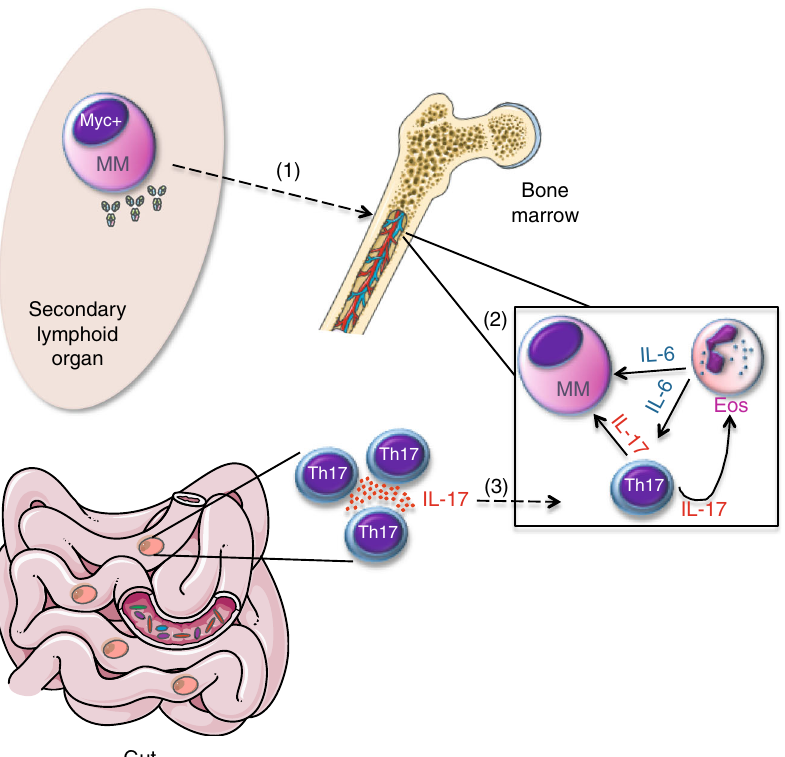
Fig. 7 IL-17-producing cells indeuced by gut microbiota favor MM progression. (1) Upon AID-dependent MYC activation in germinal centers, a B cell stochastically acquires the characteristics of malignant plasma cell (MM) and migrates to the BM. (2) Within the BM niche, a favorable cytokine milieu induces Th17 skew and eosinophil (Eos) activation, thus establishing a positive-feedback loop that is self-amplifying, and sustains MM progression. (3) A selected gut microbiota locally favors the expansion of Th17 cells, which migrate to the BM niche, where they further contribute to the eosinophil-Th17- MM cells